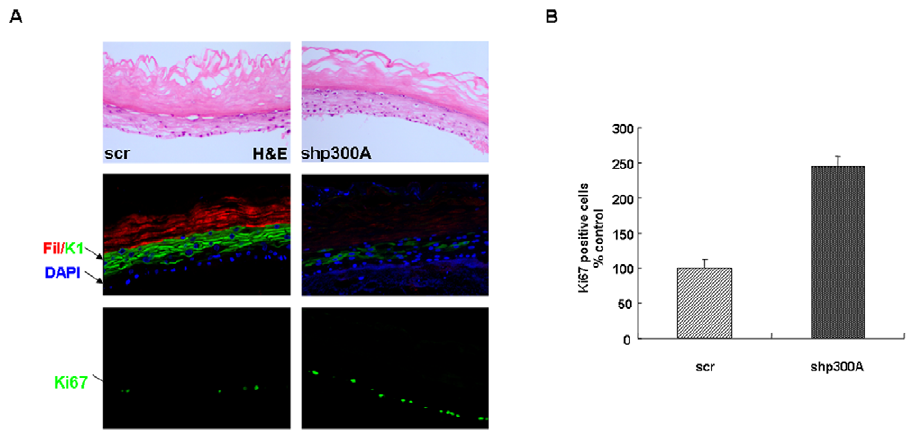
Figure 2. p300 has a role in proliferation and differentiation of organotypic keratinocyte raft cultures. ( A ) H&E staining of organotypic raft cultures of control (scr) and p300 knock down (shp300A) cells (upper panel). Immunostaining of raft sections indicates that level of early marker keratin 1 (K1) and late marker filaggrin (Fil) are significantly reduced in knockdown cells (middle panel). Ki67 immunostaining reveals that there is an increase in the number of proliferative cells in the basal layer of p300 knockdown rafts compared to control (lower panel). ( B ) Graph represents percentage of Ki67 positive cells in p300 depleted cells, expressed relative to scrambled control (Mean + / 2 SE, two independent biological